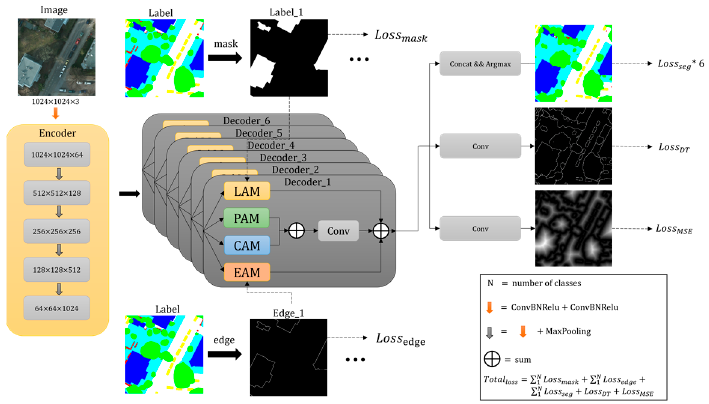
Figure 2. An overview of the Multi-task QANet (MQANet).